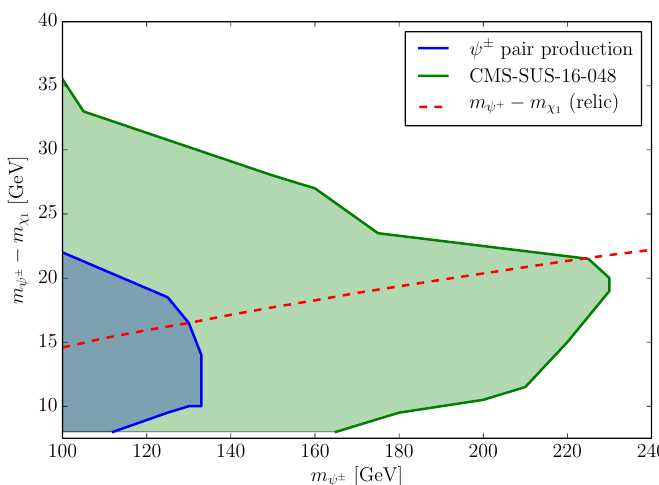
Figure 4 . (Left panel) Exclusions from the CMS dilepton search [27] interpreted in the triplet model. Blue curve: